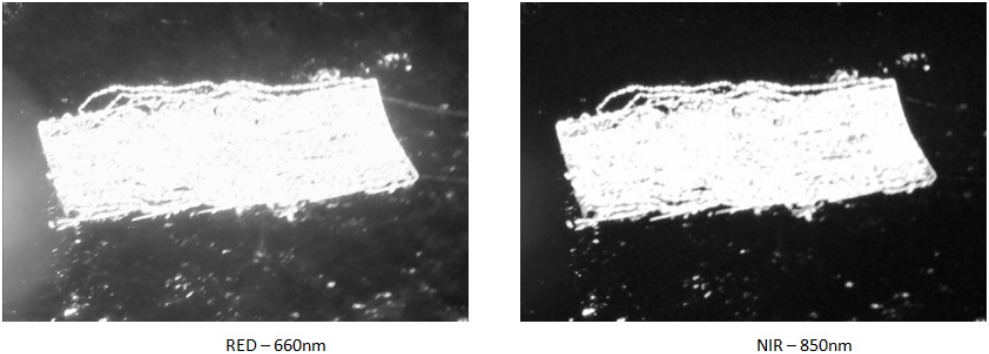
Figure 6. Left : target as evident at 660nm. Right : target as evident at 850nm (Sony Exmor camera).